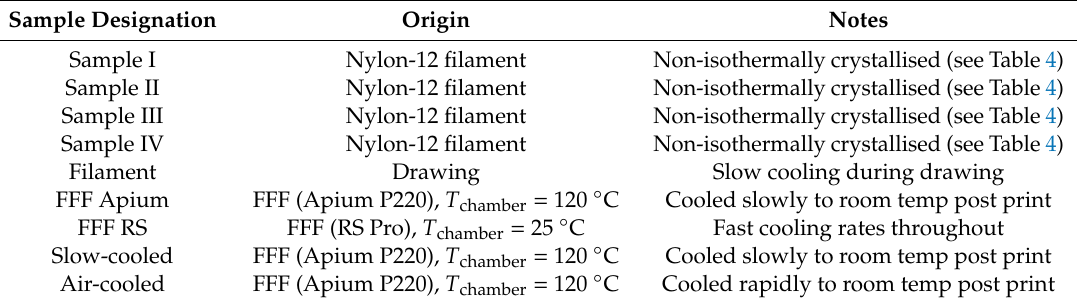
Table 3. List of samples tested by wide-angle x-ray scattering (WAXS).